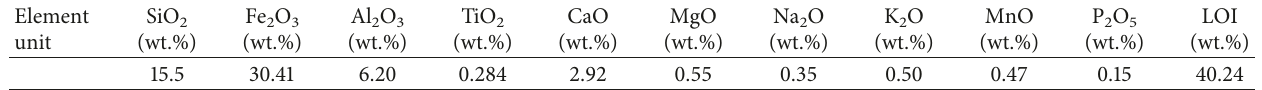
Table 1: Main chemical compositions of the studied lead-zinc smelting slag. Element